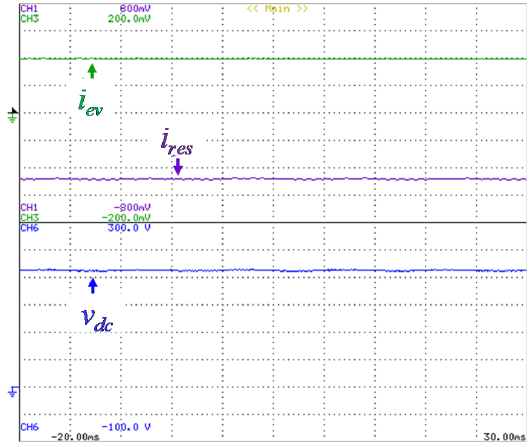
Figure 21. Experimental results during the MF-EVCS operation in R2G mode combined with R2V mode: ( a ) Harmonic spectrum of the total home current ( i g ); ( b ) Operating powers and total power factor.